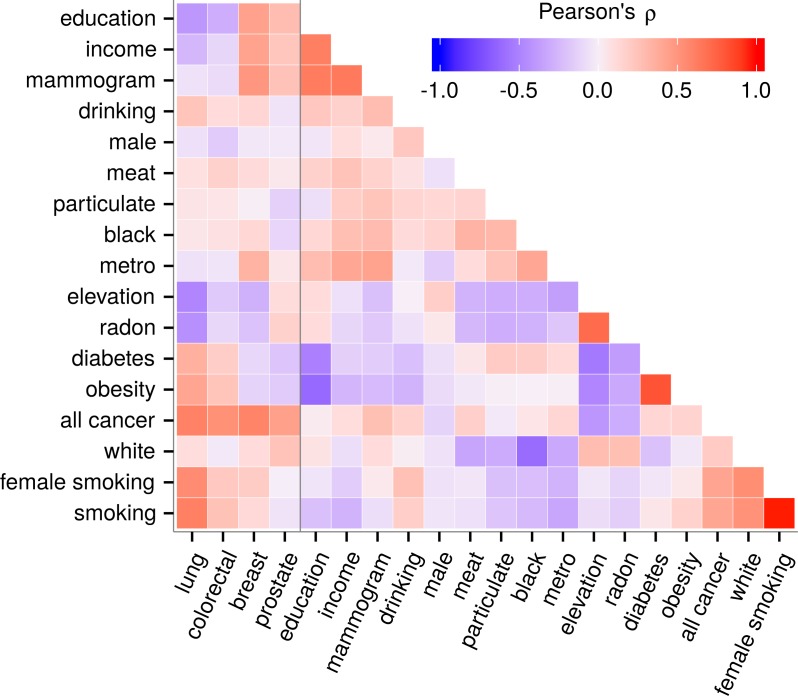
Predictor collinearity and correlation with cancer incidence.Predictors displayed expected correlations such as a strong positive correlation between obesity and diabetes. Collinearity was moderate but pervasive. Elevation covaried with most variables including cancers indicating the need to adjust for covariates while carefully considering collinearity. Besides radon, the correlation of elevation with other predictors did not exceed |ρ| = 0.55.